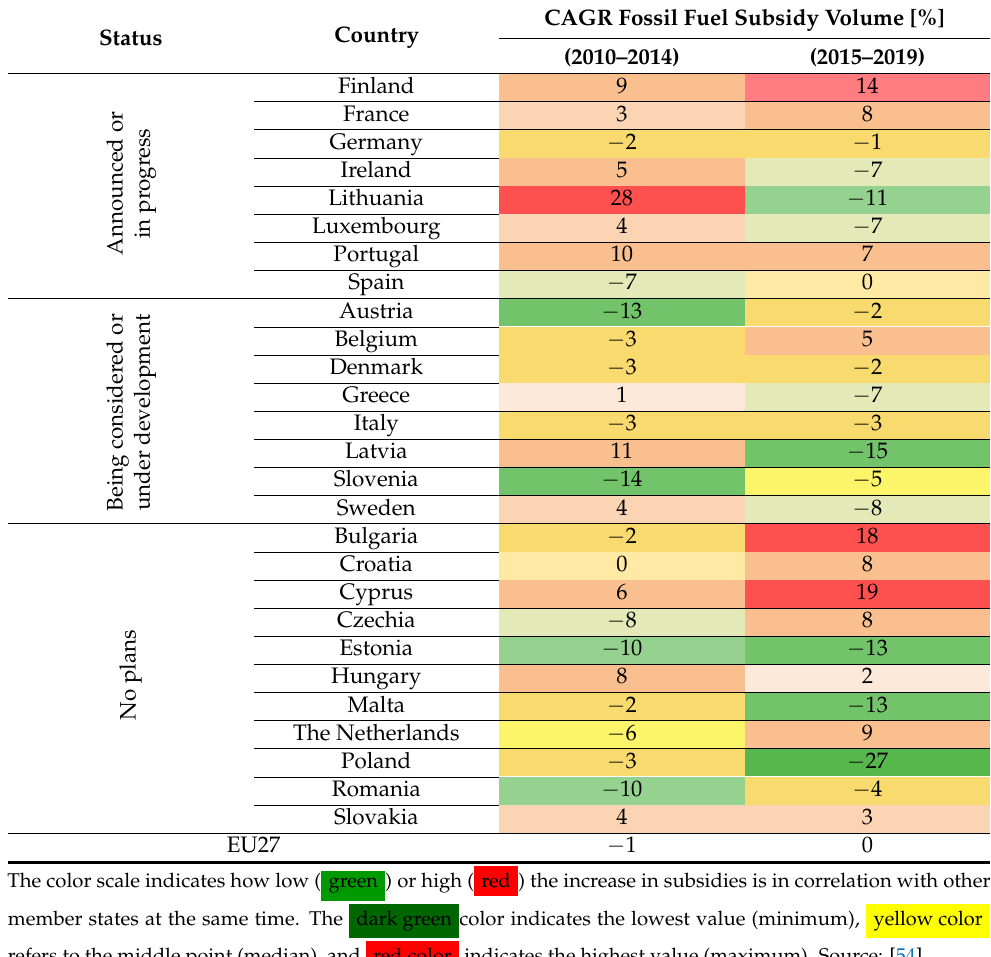
Table 3. Status of MS commitments to phase out fossil fuel subsidies and changes (in CAGR)